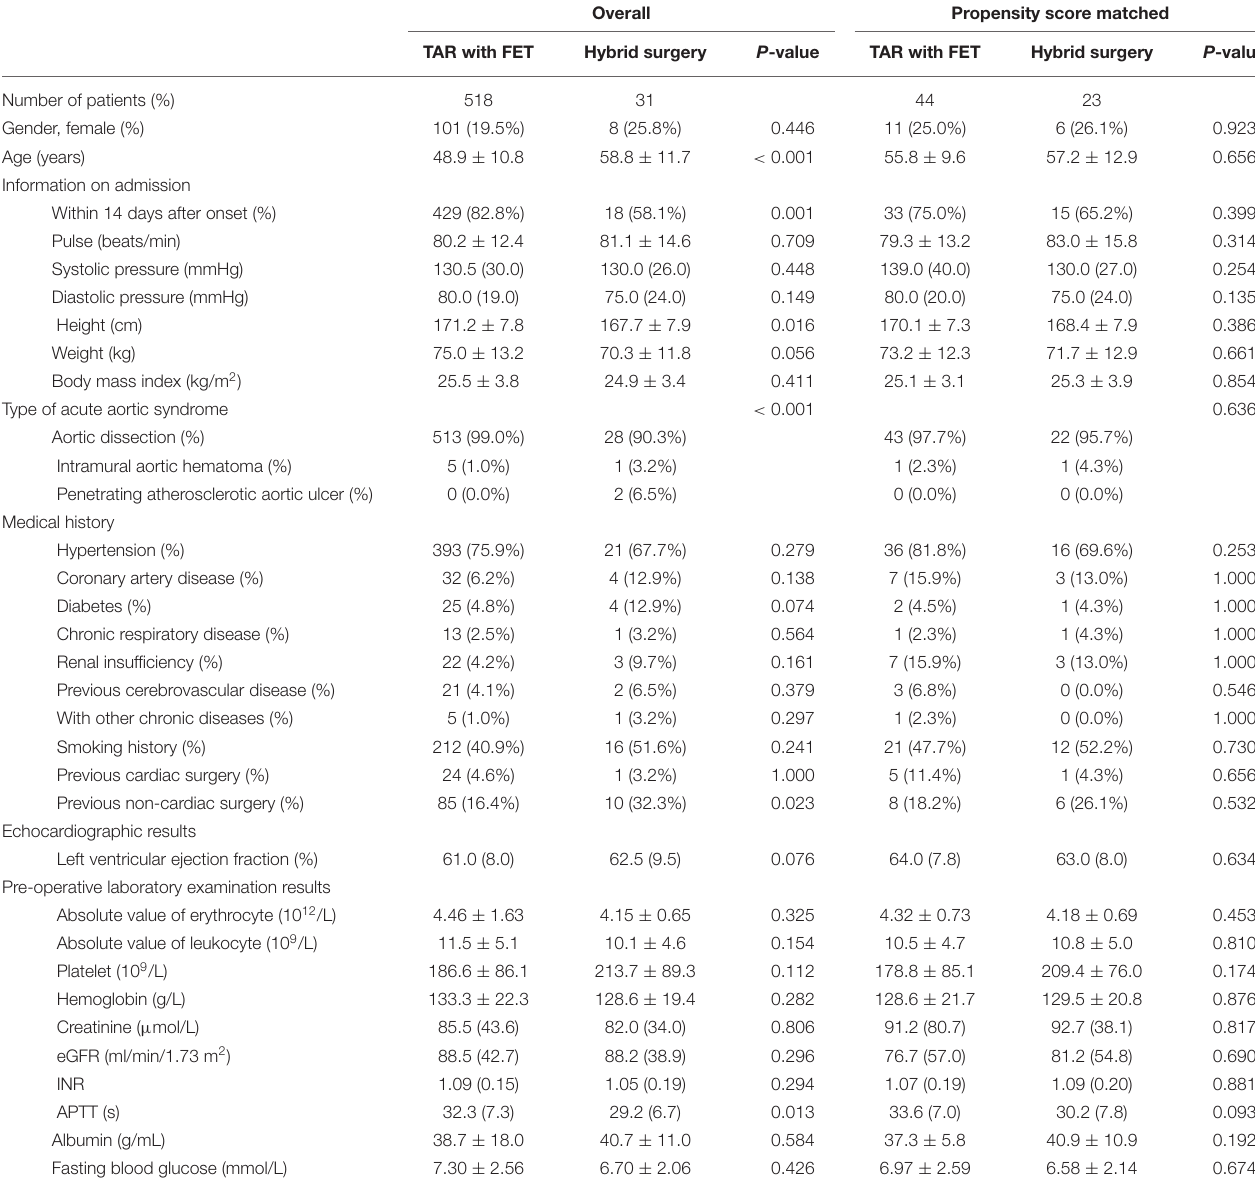
TABLE 1 | Demographic and pre-operative data. Overall Propensity score matched TAR with FET Hybrid surgery P -value TAR with FET Hybrid surgery P